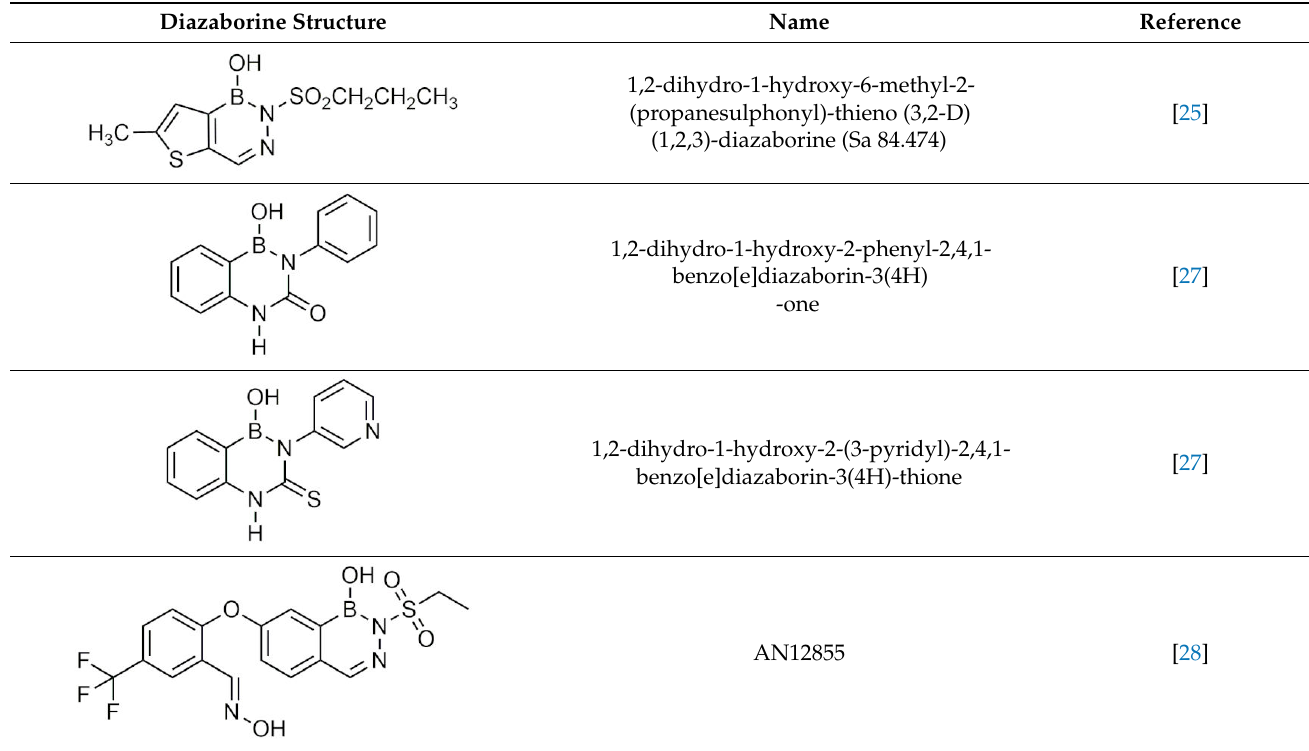
Figure 3. Boron neutron capture therapy (BNCT) agents boronophenylalanine (BPA) and mercap- toundecahydrodecaborane (BSH) with 10 B isotope. 10 B captures low energy thermal neutrons from radiation therapy and splits into a recoiled 7 Li particle and a 4 He α -particle, damaging the cancer cell resulting in cell death. Table 1. Diazaborine medicinal